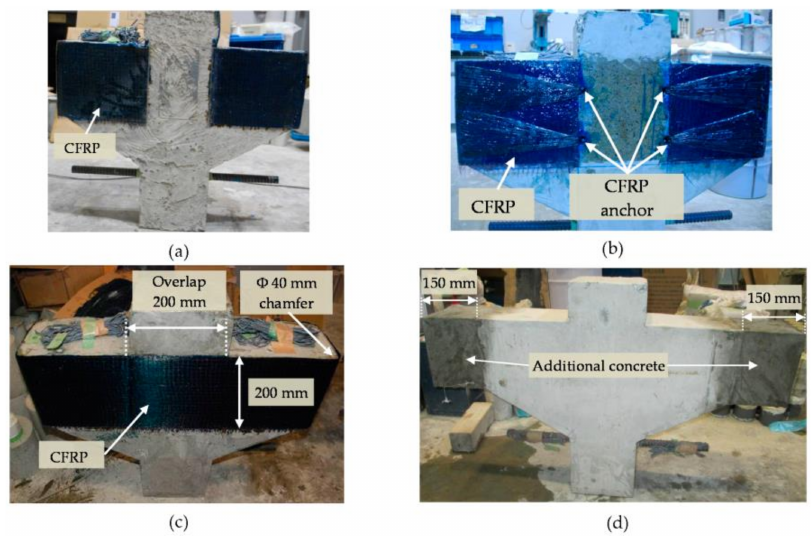
Figure 4. Experimental specimens in the second and third series: ( a ) CFRP-CF-2L; ( b ) CFRP-CF-2L(A); ( c ) CFRP-FW-1L and CFRP-FW-2L; ( d )